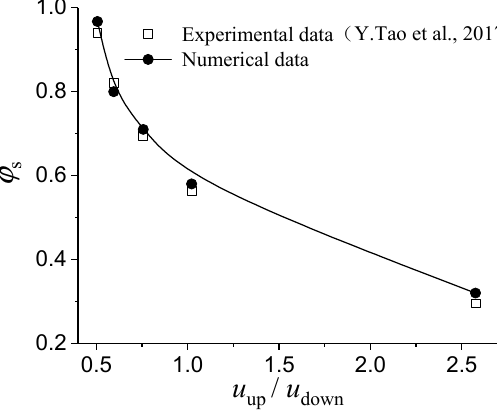
Figure 2. Impacts of u up / u down on ϕ s